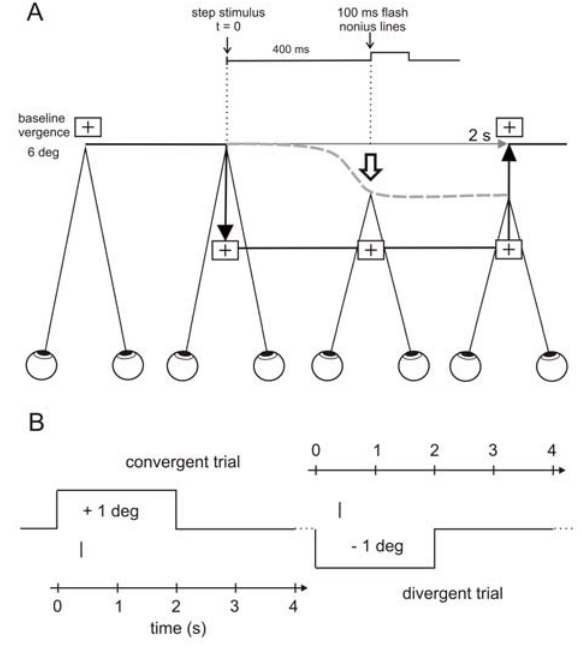
Figure 1. (A) In the beginning of a trial, the stimulus (illustrated by the central fixation cross surrounded by a rectangular frame, not to scale) is presented with zero disparity (i.e. at a baseline vergence angle of about 6 deg). At t=0, the step stimulus of disparity (convergent in this example) is presented and the eyes perform a convergent movement, schematically illustrated by the dashed line. With a delay of 400 ms, nonius lines are flashed (for 100 ms) in order to estimate the vergence state reached within 400 ms (indicated by the open arrow). At 2 s after onset of the convergent step stimulus, the baseline vergence stimulus appears again. (B) A sequence of a convergent and a divergent trial with a disparity step stimulus of 1 deg. The tick on the time axis indicates the moment when the nonius lines were flashed. 20 convergent and 20 divergent trials were randomly interleaved in order to run two psychometric procedures, one for each vergence